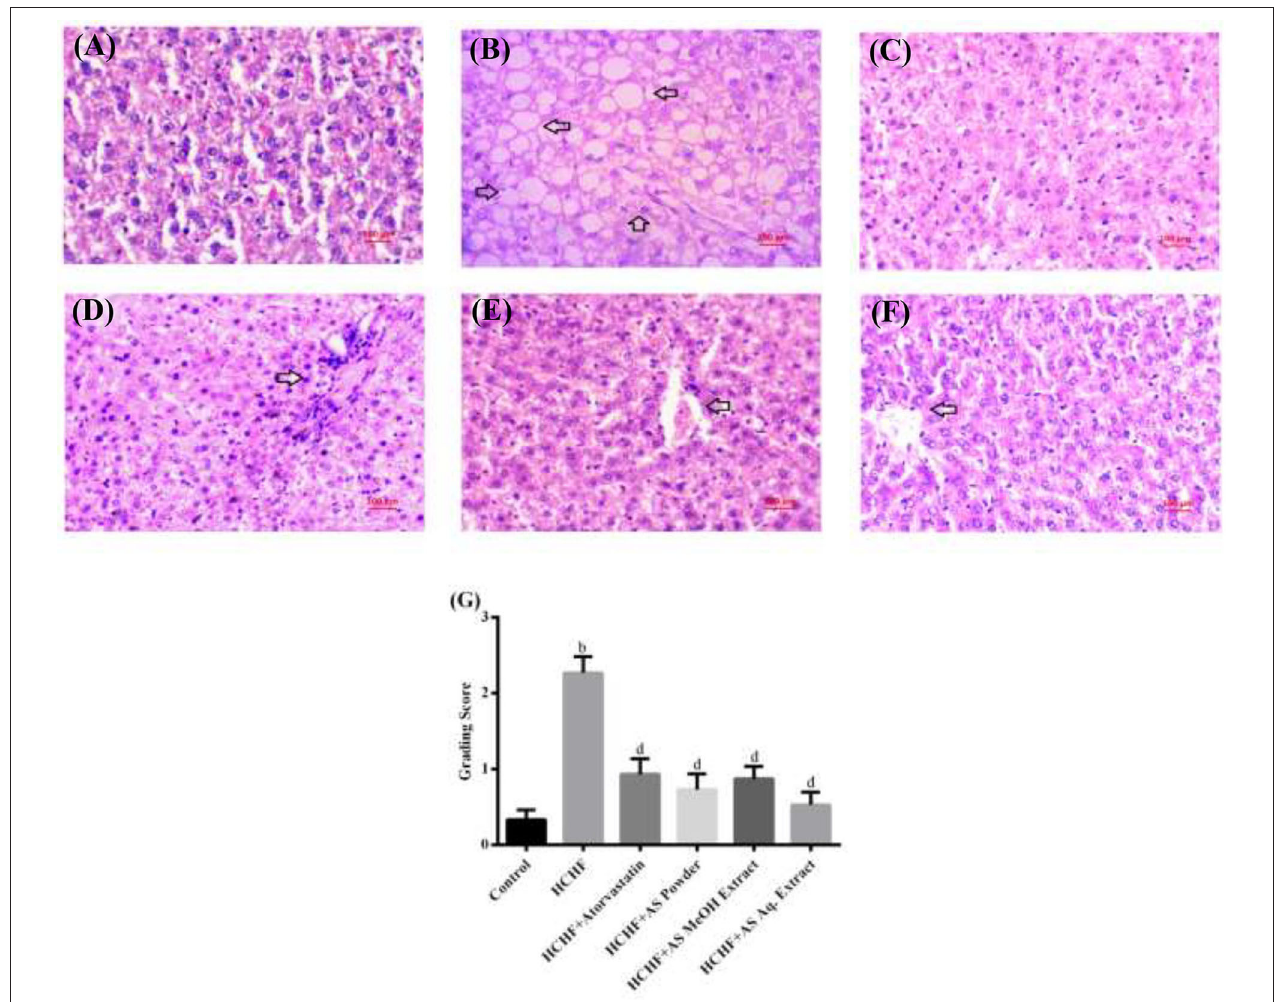
FIGURE 6 | Liver sections from (A) control group, (B) HCHF diet group, (C) HCHF + Atorvastatin group, (D) HCHF + Amaranthus spinosus powder group, (E) HCHF + Amaranthus spinosus MeOH extract group, and (F) HCHF + Amaranthus spinosus Aq. extract group. Arrows indicate fat infiltration. Magnification is 40 × . (G) Scores of steatosis among different treatment groups. Values are presented as mean ± SD, where n = 15. b p < 0.005 vs. control; d p < 0.005 vs.